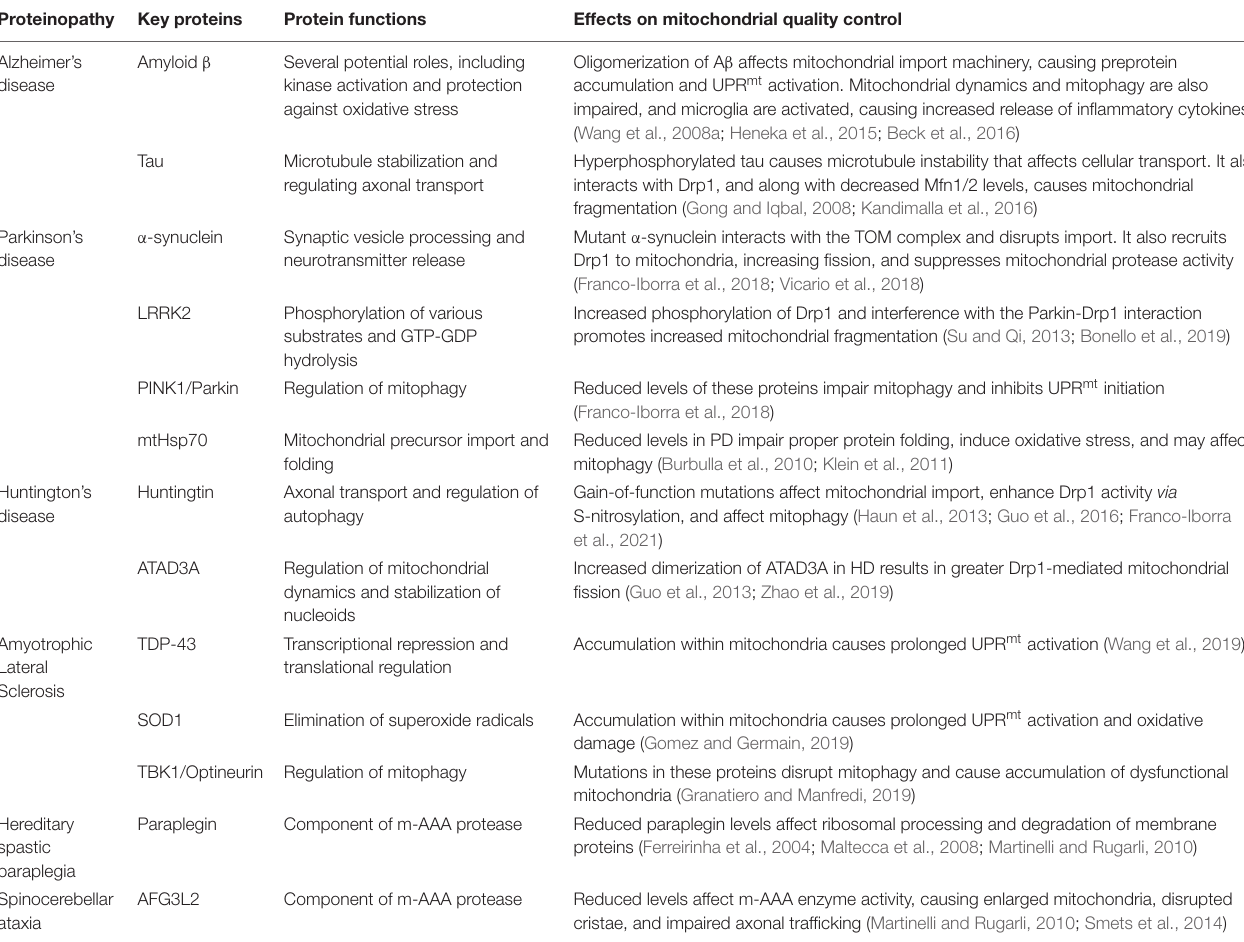
TABLE 1 | A summary of mitochondrial protein homeostasis dysregulation in neurodegeneration. Proteinopathy Key